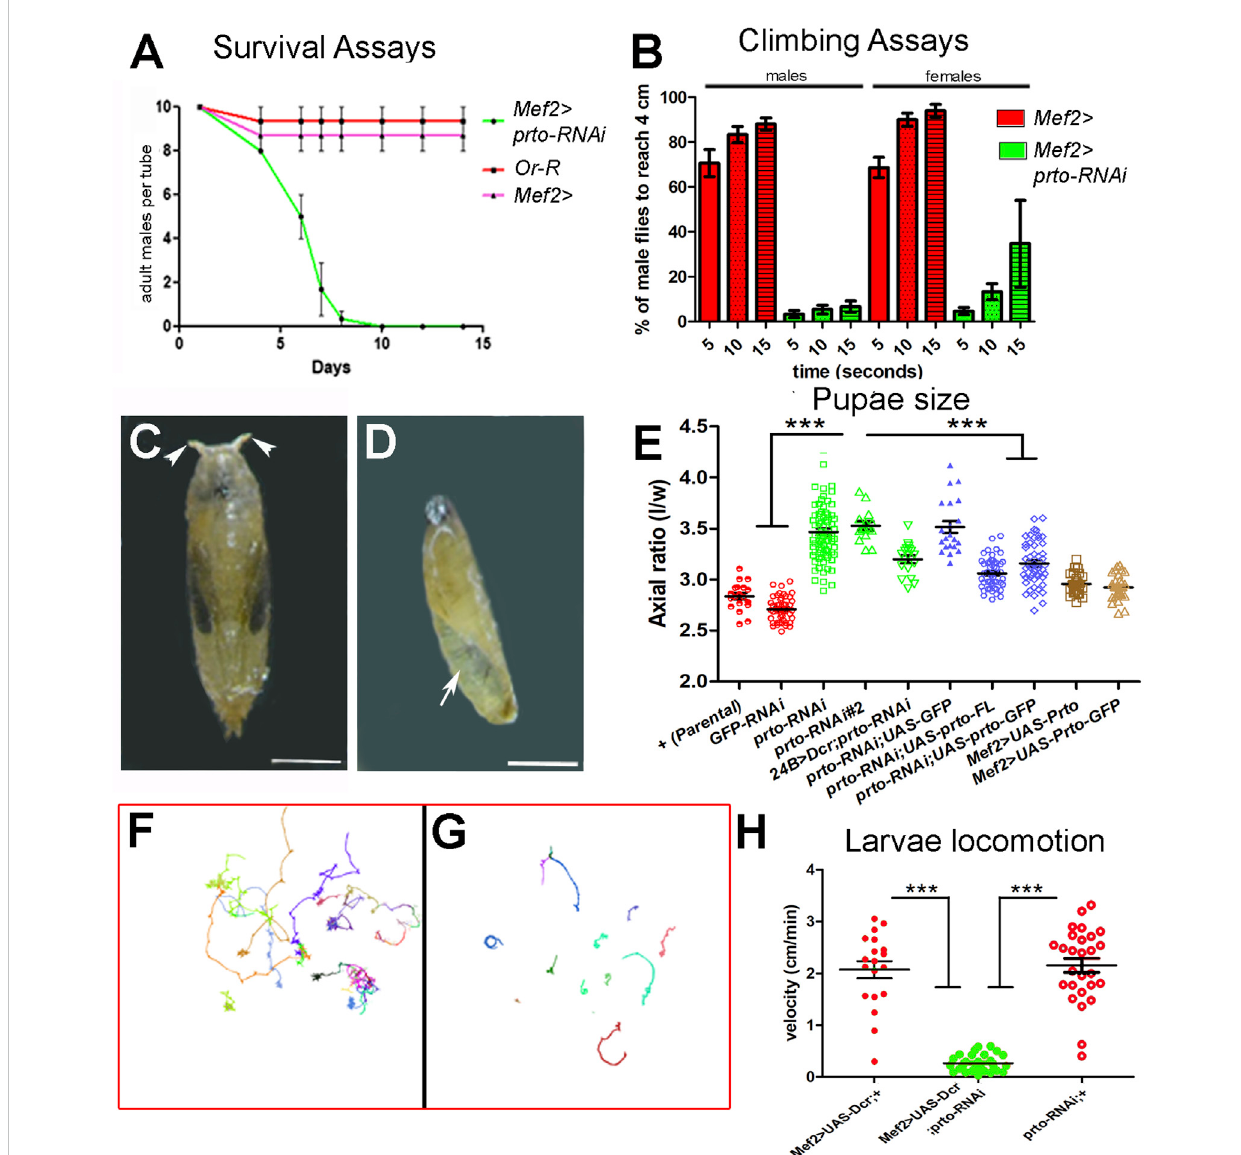
FIGURE 2 prto knock-down phenotypic analyses. (A) Survival assays of male adult fl ies showing a striking reduction of viability in Mef2 > prto-RNAi males in comparison to parental Mef2 > control and wild-type Or-R males at 29 ° C. n = 10 per replica, 3 replicas, error bars represent 95% CI. (B) Climbing analysis showsthat both Mef2 > prto-RNAi maleand female fl ieshave areduced locomotion ability onreaching4 cmmark ingeotaxisexperimentsincomparison to controls (29 ° C). 1way ANOVA with Bonferroni post test statistical analysis was carried out. n = 15 per replica, error bars represent 95% CI. (C,D) Pupalcasesofcontrol (C) and Mef2 > UAS-Dcr;prto-RNAi (D) at29 ° C.Notethat prto KDpupaearesmallerinsize,rarelydifferentiateadultstructures,retain air bubble (arrow) and they lack anterior spiracles (arrowheads). Scale bar 1 mm. (E) Axial ratio measurements (length/width) of pupal case of controls (red), prto-RNAi KDs (green), rescue genotypes (blue) showing prto speci fi city of phenotype and ectopic prto full-length and GFP-tagged expression (brown) in the muscles. All knockdown, rescue and overexpression lines were driven with Mef2-Gal4 unless otherwise indicated 1 way ANOVA